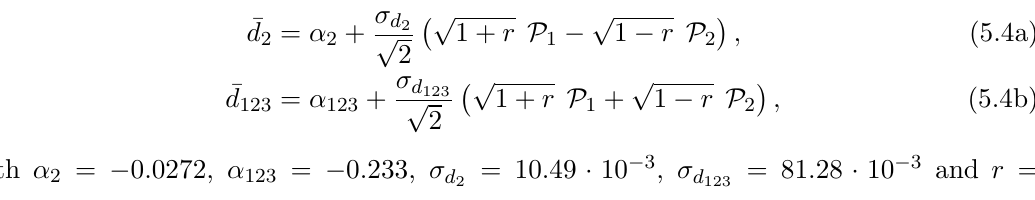
Table 8 . Correlation matrix for our best (cid:12)t (excluding BaBar (cid:25) 0 -TFF data). We now focus on the (cid:12)t to TFF data and eqs. (5.3a){(5.3d). A preliminary (cid:12)t with f (cid:18) M e V and (cid:22) d 2 and (cid:22) d 123 shows a correlation between the latter two close to one. V , 8 = 0 , 8 = 0 , m Hence, instead of considering (cid:22) d 2 and (cid:22) d 123 , we will (cid:12)t the parameters P 1 and P 2 provided by the linear